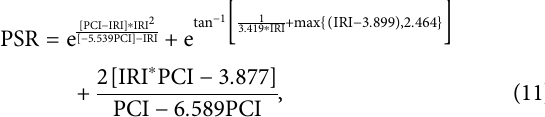
Frontiers in Built Environment |